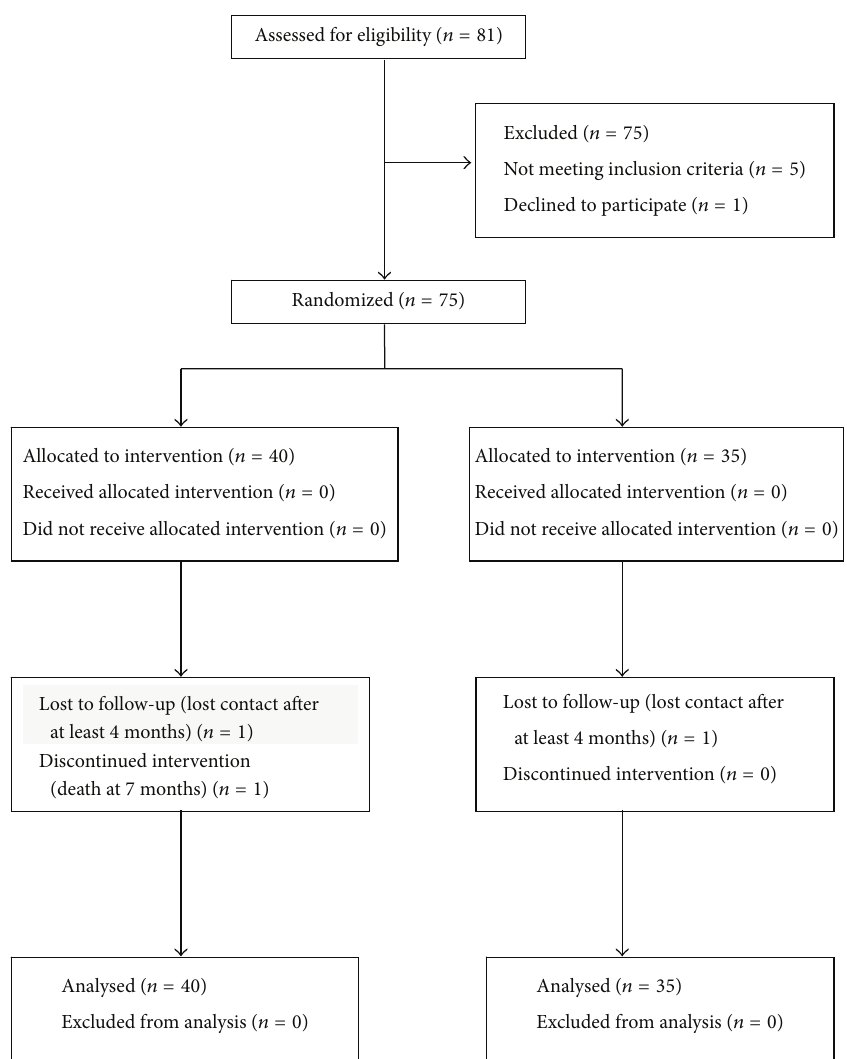
Figure 1: Flow chart for the